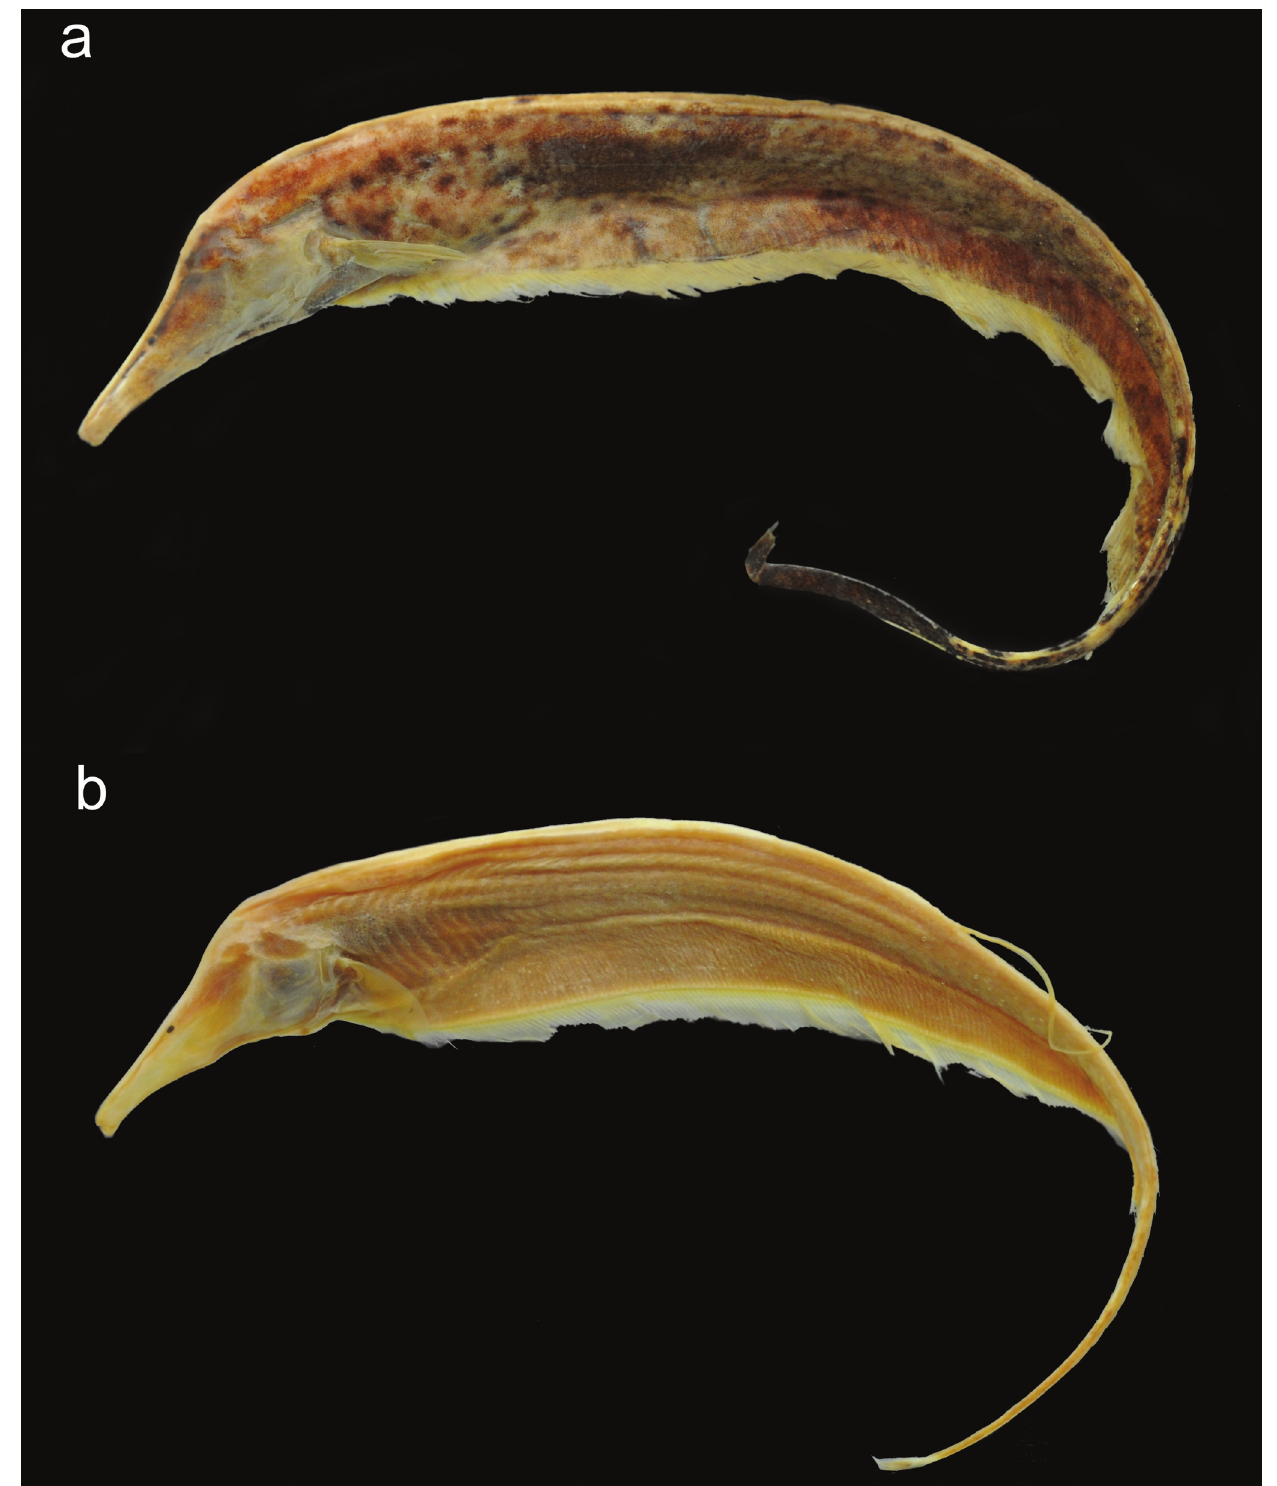
Fig. 1. Lateral view of the paratypes of Apteronotus magdalenensis : a ) BMNH 1947.7.1.38, 335 mm TL.; b ) USNM 123795, 287 mm